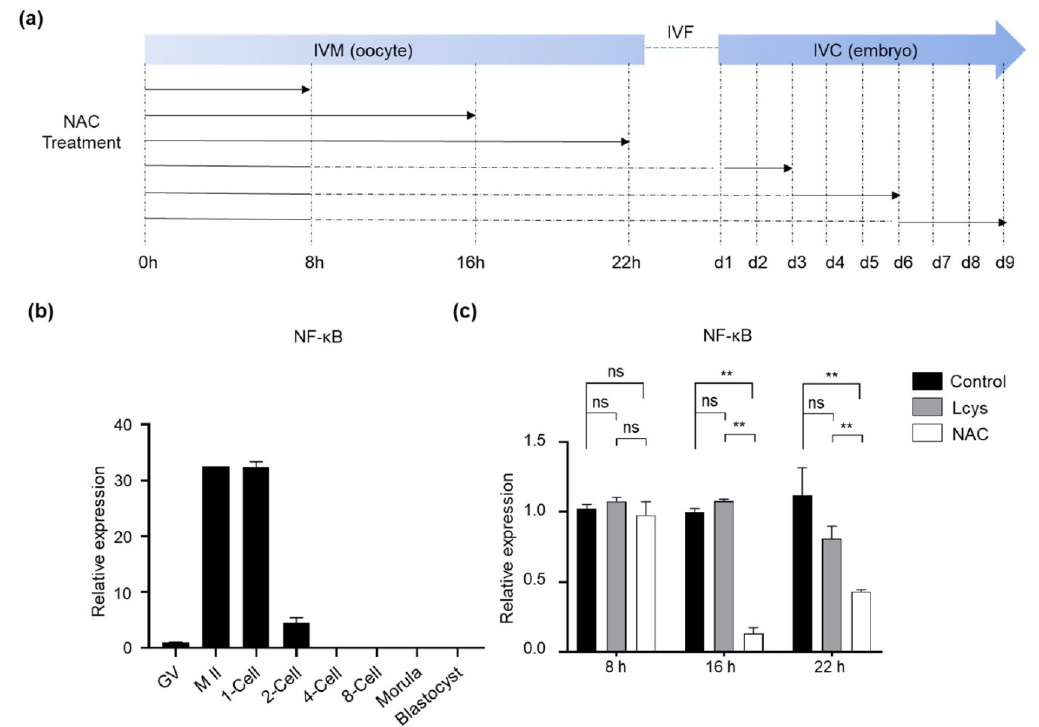
Figure 1. The effects of NAC supplementation on the expression of NFKB1 gene in bovine oocytes and embryos. ( a ) Schematic of NAC supplementation timeline. Solid lines represent the period that oocytes or embryos were cultured in medium with NAC, while dashed lines represent the period without NAC. ( b ) NFKB1 mRNA expression levels in oocytes and IVF-derived embryos cultured under basic medium (control). ( c ) Time-dependent inhibitory effects of NAC supplementation during IVM on NFKB1 expression in oocytes. NAC, N-acetyl-L-cysteine; Lcys, L-cysteine; IVM, in vitro maturation; IVF, in vitro fertilization; IVC, in vitro culture; NFKB1 , nuclear factor kappa B subunit 1; GV, germinal vesicle; M II, metaphase II. Values are means ± SEM calculated from three replicates; ns, no significant difference; **, p < 0.01.